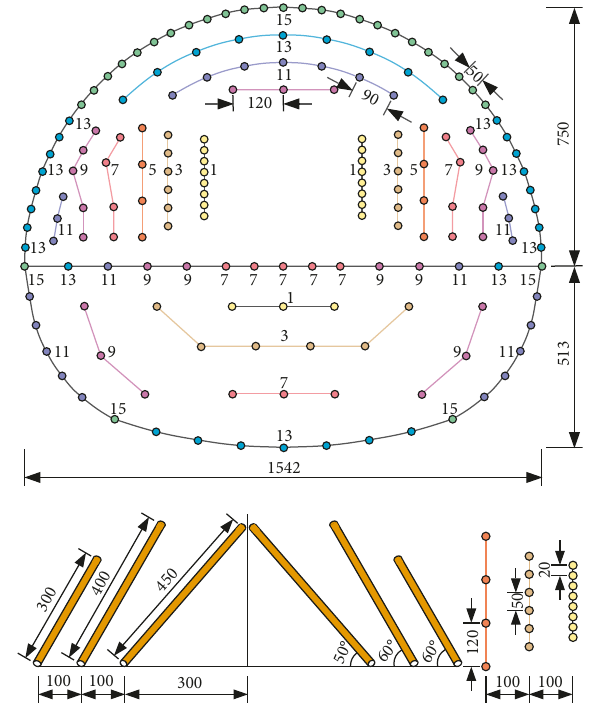
Figure 3: Blast hole layout (unit: cm). Note: the number in the figure is the detonator segment. Table 1: Parameters of the upper step